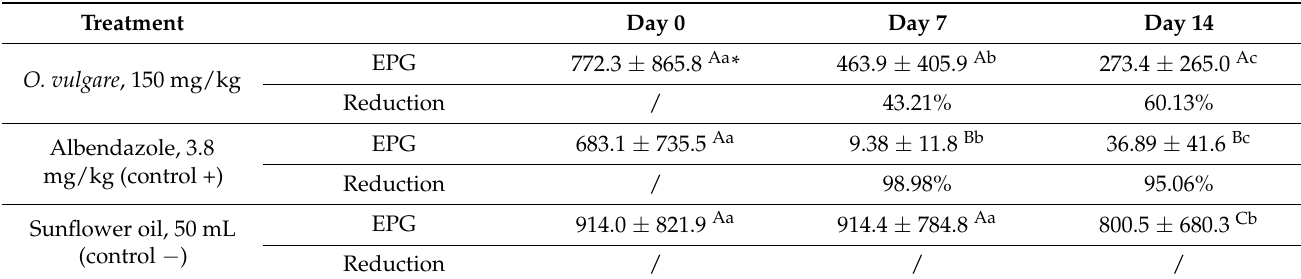
Table 3. EPG (mean ± standard deviation) of sheep gastrointestinal nematodes and efficacy (reduction %) of the Origanum vulgare essential oil based on fecal egg count reduction test—in total from both examined